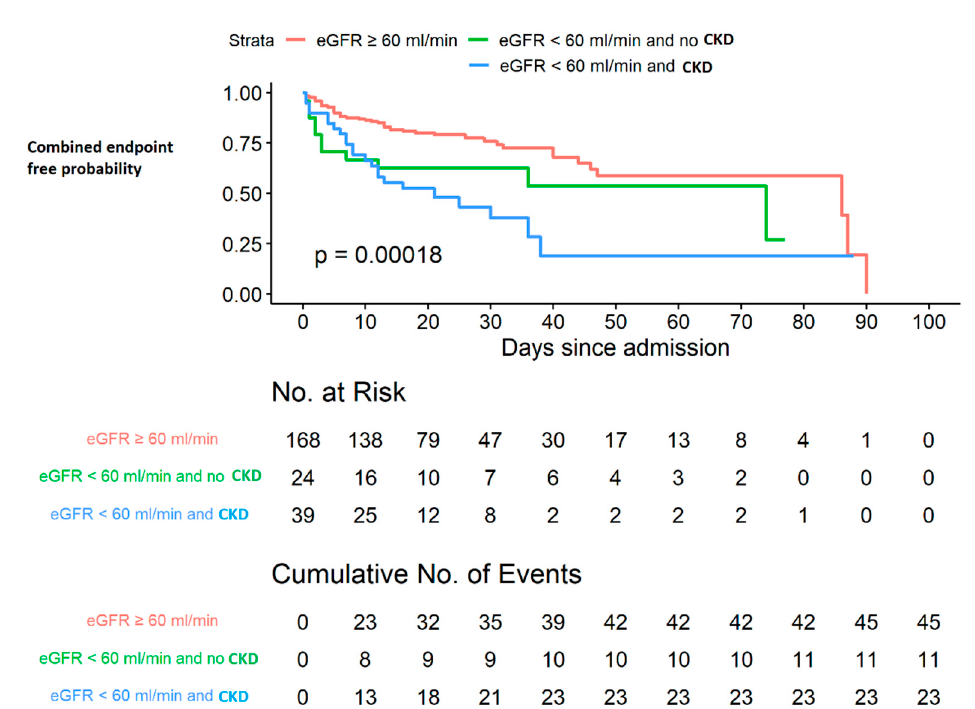
Figure 3. Kaplan–Meier survival curves for the main outcome (admission to ICU or death) in the pooled sample divided into three groups according to eGFR and CKD (global log-rank test p < 0.001).